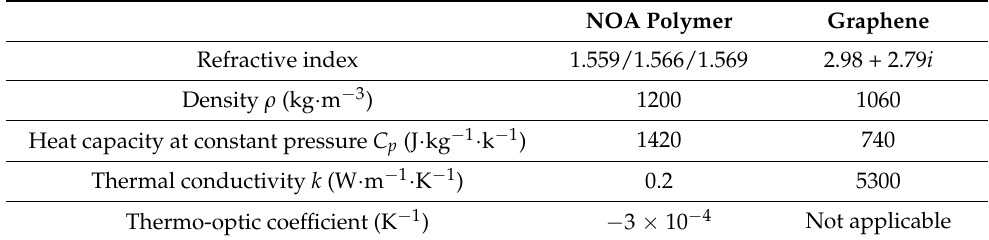
Table 2. The imaginary part of the effective refractive index for three cores.